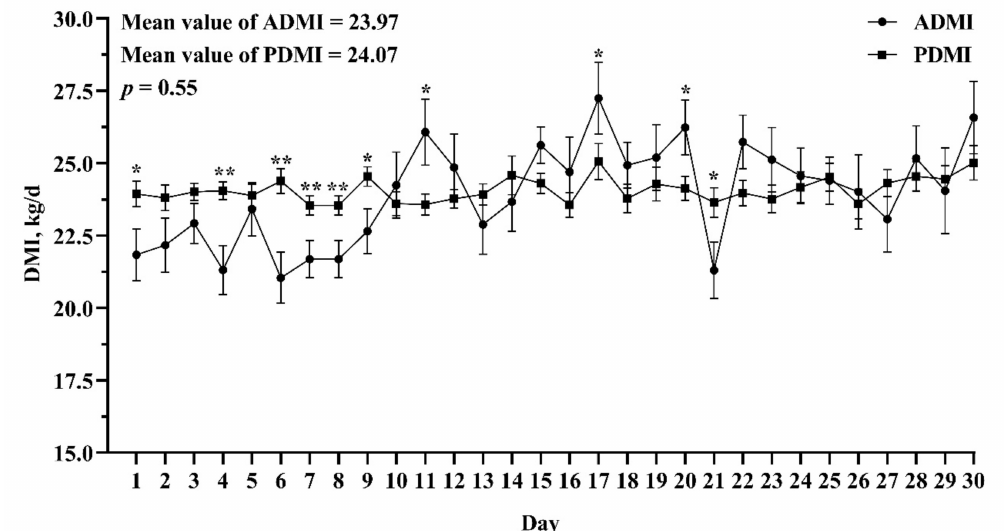
Figure 3. Comparison of actual dry matter intake (ADMI) and predicted dry matter intake (PDMI) in every day in the validation datasets. Bars indicate SEM. The * and ** indicate a significant difference between ADMI and PDMI in the individual day at p < 0.05 and p < 0.01, respectively.